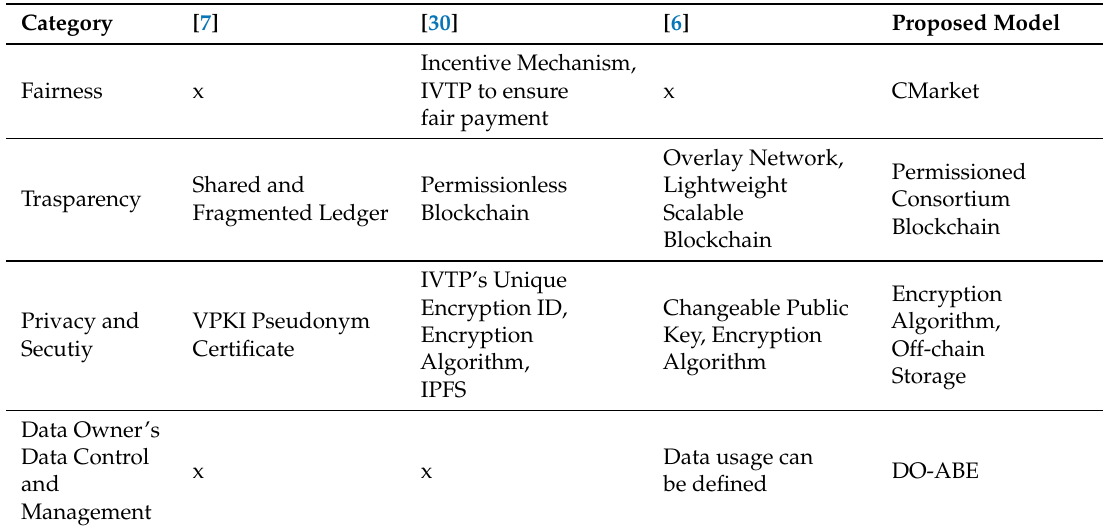
Table 2. Comparative analysis of the existing models and the proposed